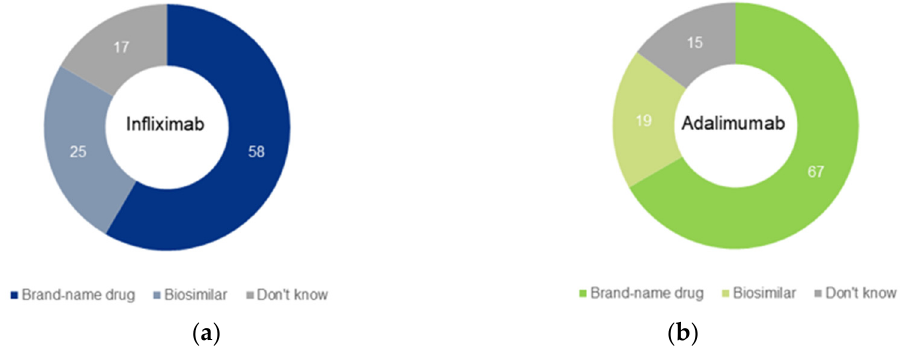
Figure 2. Treatment preference in the case of no binding guidelines, regarding infliximab ( a ) and adalimumab ( b ).